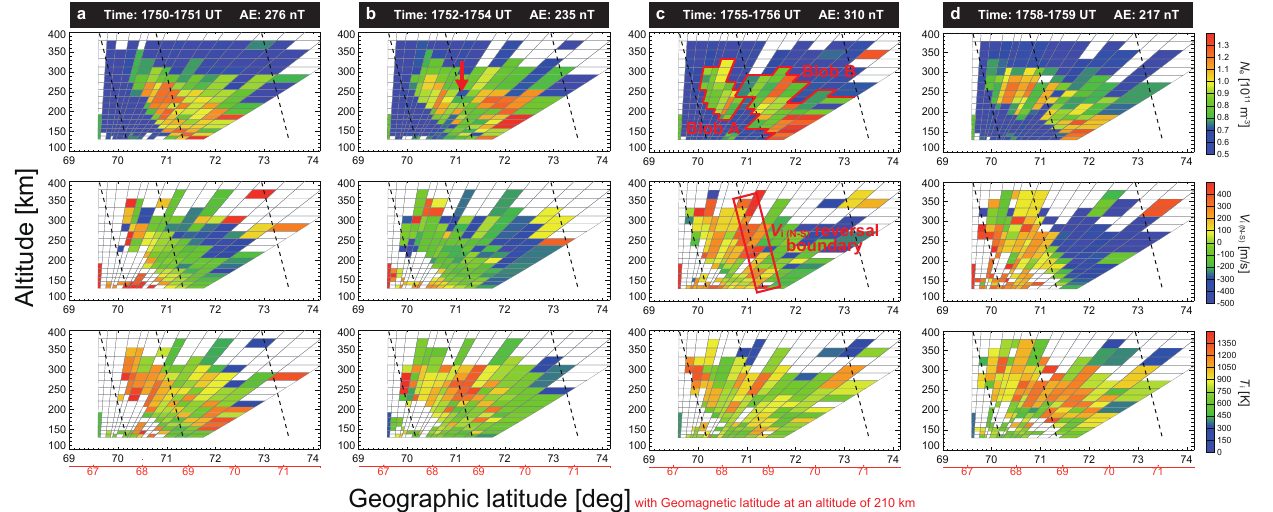
Figure 3. The temporal evolution of a blob on the meridional plane during Fig. 1e–f, with geographic latitudes on the horizontal axes and altitudes on the vertical axes: (top) N e , (middle) V i ( N − S ) , and (bottom) T i . Dashed slant lines indicate the geomagnetic field lines. Red horizontal axes indicate the geomagnetic latitudes at an altitude of 210km.